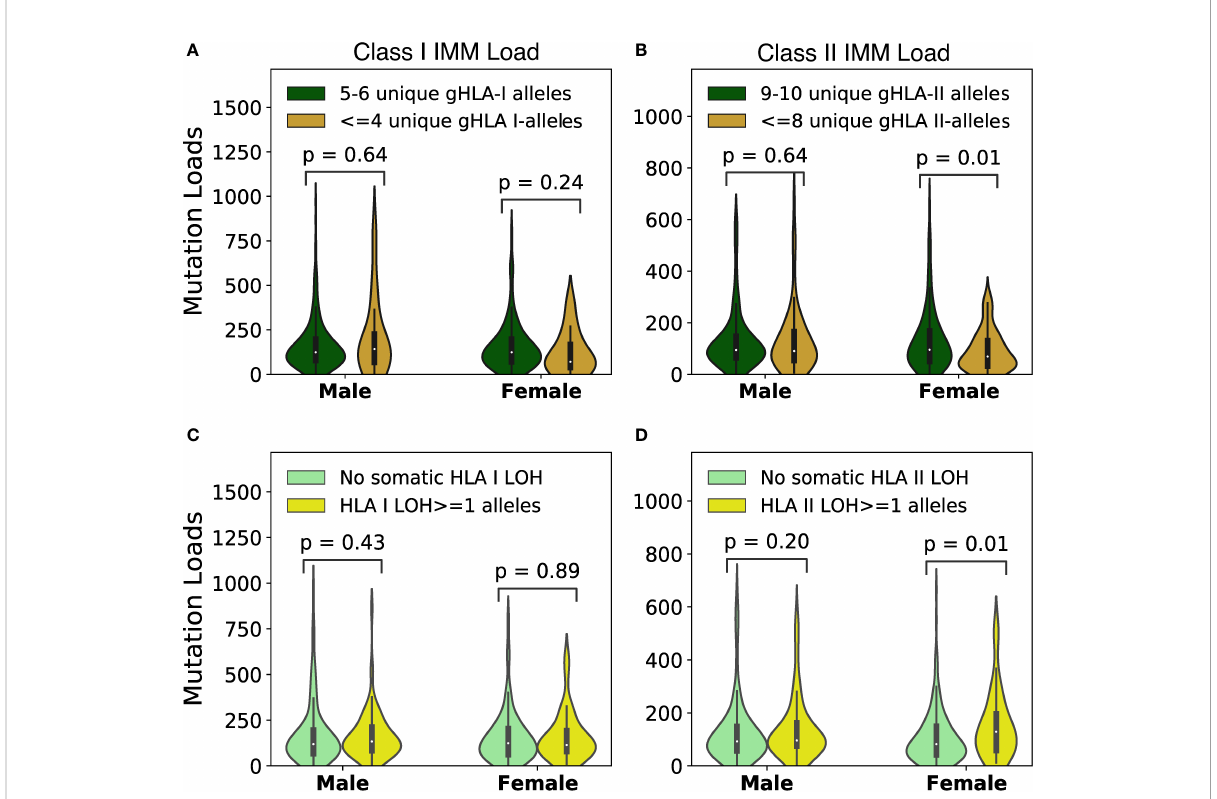
FIGURE 1 Background immunogenic mutation association with HLA diversity in TCGA-NSCLC cohort. (A) No association between class I IMM loads and tumor HLA I diversities was found in either males (MW p=0.64) or females (MW p=0.24). (B) Female tumors with high germline HLA II diversity had signi fi cantly higher class II IMM loads (MW p=0.01). Male tumors did not show class II IMM load difference between the high germline HLA II diversity and the low germline HLA II diversity groups (MW p=0.64). (C) No association between loss of heterozygosity (LOH) of HLA I alleles and class I IMM loads were identi fi ed in either males (MW p=0.43) or females (MW p=0.89). (D) Female tumors lost ≥ 1 HLA II alleles had higher class II IMM loads than those with no LOH (MW p=0.01). LOH for HLA II alleles did not associate with class II IMM load difference in male tumors (MW